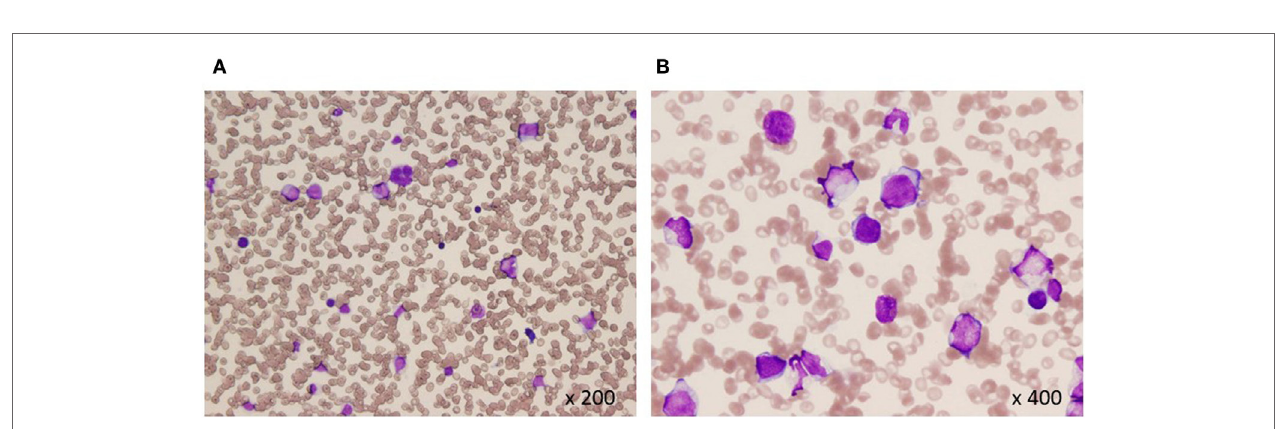
FIGURe 2 | Bone marrow aspiration at diagnosis (a,B) . Hypocellular bone marrow with 14% blasts and dysplasia in all cell lineages (May-Giemsa).